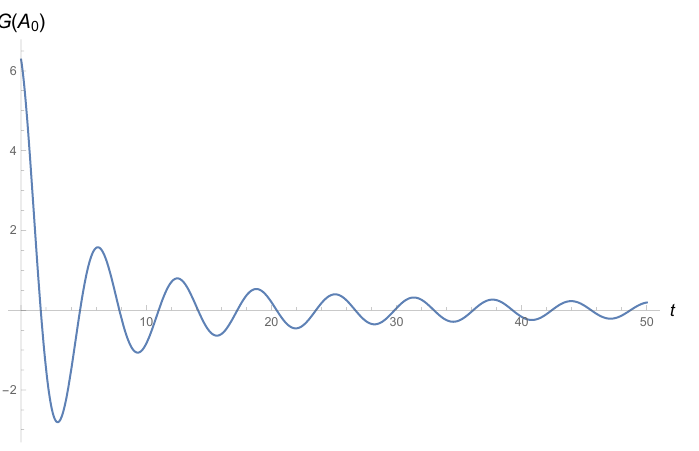
Figure 2 . A plot of the two point function in the A 0 phase ( (cid:22) = 1 ; (cid:12) = 10 ; L = 1). It oscillates and decays with a power law.